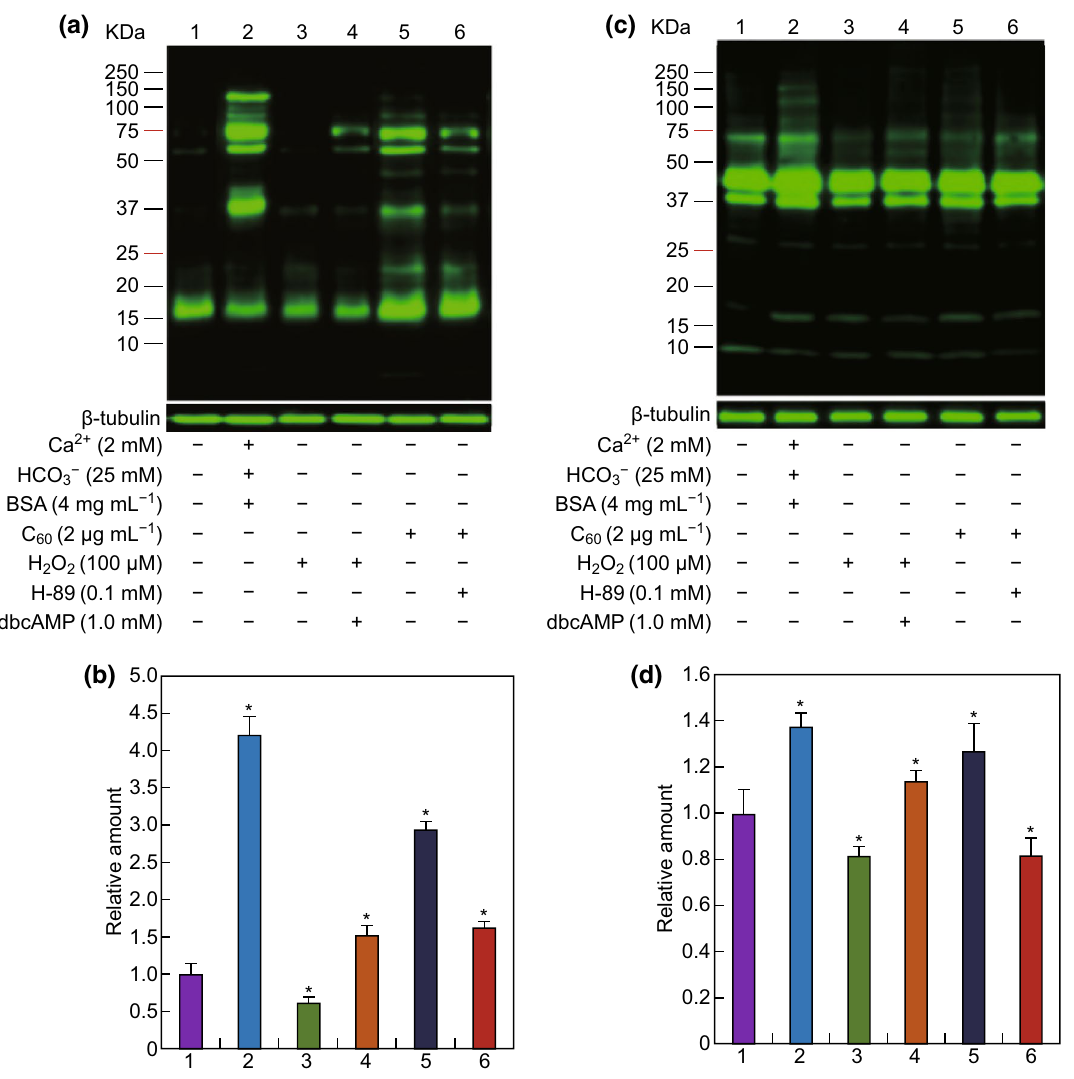
Fig. 7 Effects of the cAMP-PKA pathway-related regulatory factors on P-PKAs and PTP with different concentrations of carboxylated C 60 . a Western blot was performed using an anti-phospho-PKA substrate antibody. b Densitometric analysis of the western blot image shown in a . c Western blot was performed using an anti-phosphotyrosine antibody. d Densitometric analysis of the western blot image shown in c . Spermato- zoa were incubated in basal medium supplemented with 100 μM H 2 O 2 in the presence or absence of 1.0 mM dbcAMP, or 2 μg mL −1 carboxy- lated C 60 in the presence or absence of 0.1 mM H-89. β-Tubulin was used as an internal control. The experiment was performed at least three times, and the image presented is representative and repeatable. (n = 3, P <